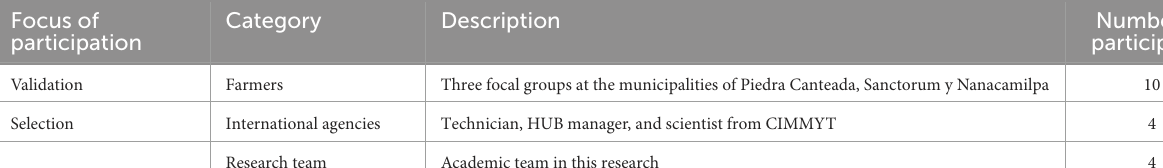
TABLE 3 Participants for the selection and validation of nature’s contributions.